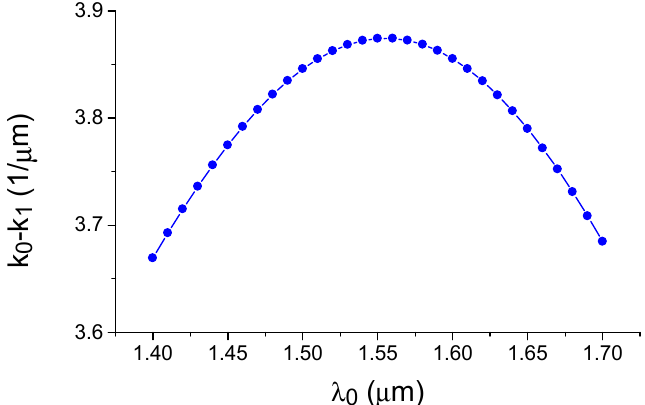
Figure 4. Dependence of the difference between the wave vectors of the fundamental and first TE modes of the silicon waveguide on the wavelength. Calculation by the effective index method.